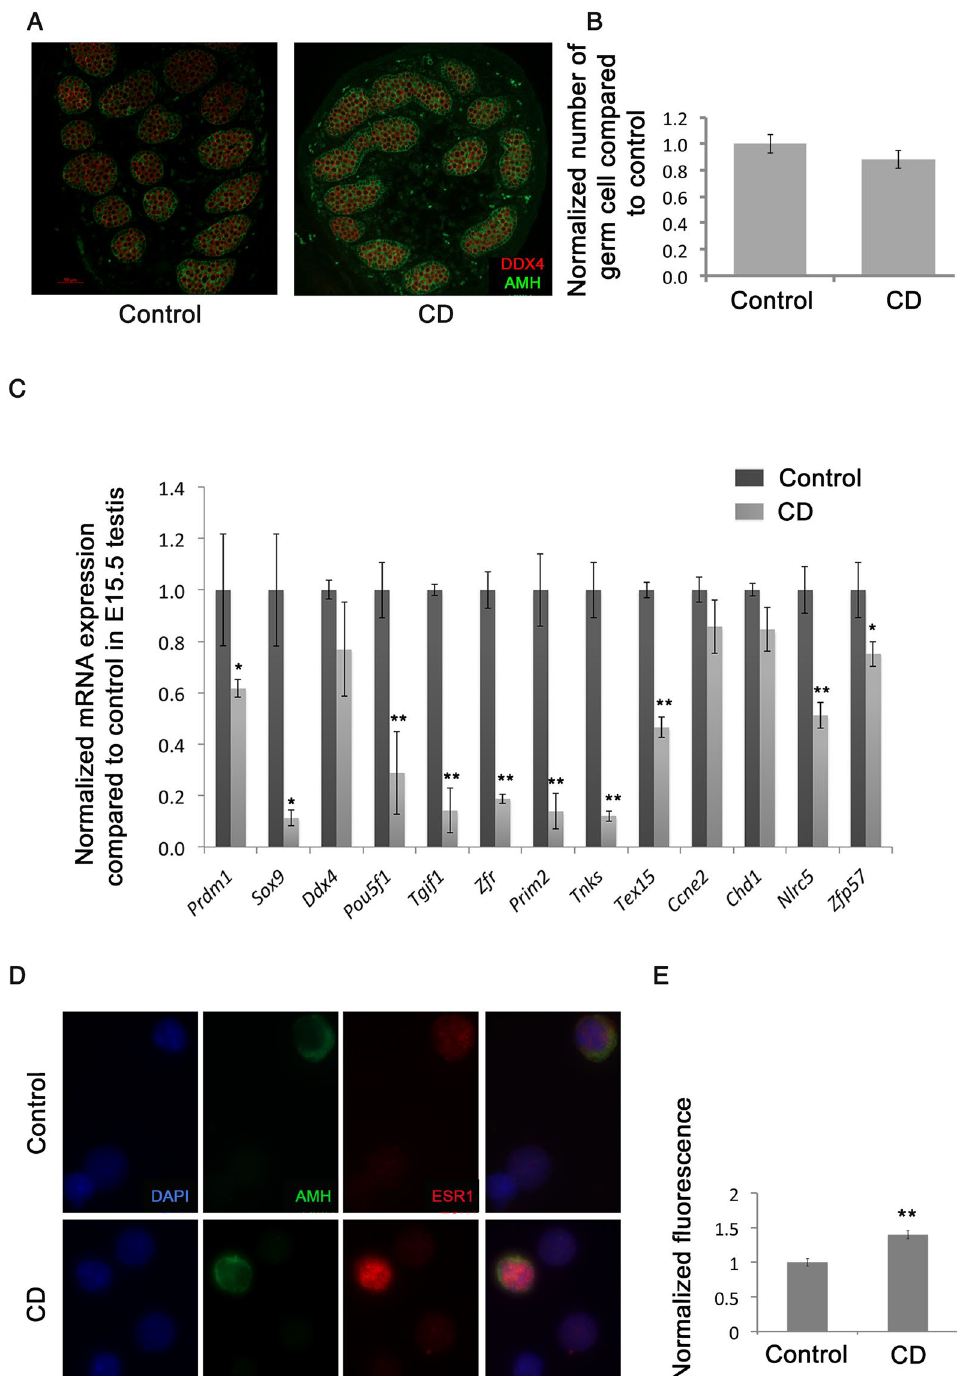
Figure 1. Gestational CD exposure affects F1 embryonic germ cells. ( A ) Representative images of testes sections from the control (left panel) and CD lineage (right panel) animals. Sertoli and prospermatogonial germ cells were immunostained using anti-Anti Müllerian Hormone (AMH, green) or anti-DDX4 (red) antibodies, respectively, scale bar 50 µ m. ( B ) A quantitative analysis of germ cells was performed by manually counting the cells in the seminiferous tubules in E15.5 mouse testes. The contour of each tubule section was measured using Adobe Photoshop. The values indicate the germ cell numbers compared to control. The bar indicates the mean value + / − SEM, (p = 0.176, n = 4 control, n = 5 CD samples, t-test). ( C ) The RT–qPCR analysis in F1 E15.5 testis. RNA was extracted and reverse transcribed as described in material and methods, qPCR was performed using primers indicated in SI. The gene copy numbers were normalized against Hprt gene and expressed as fold changes compared to control, * p < 0.5, ** p < 0.01, t-test, n = 4, for control and CD, each biological replicate represents pooled testes. ( D ) A representative image of isolated E15.5 cells from testes. Testis cells were immunostained using anti-AMH1 (green) or anti-ESR1 (red) antibodies. In control (top panel) or